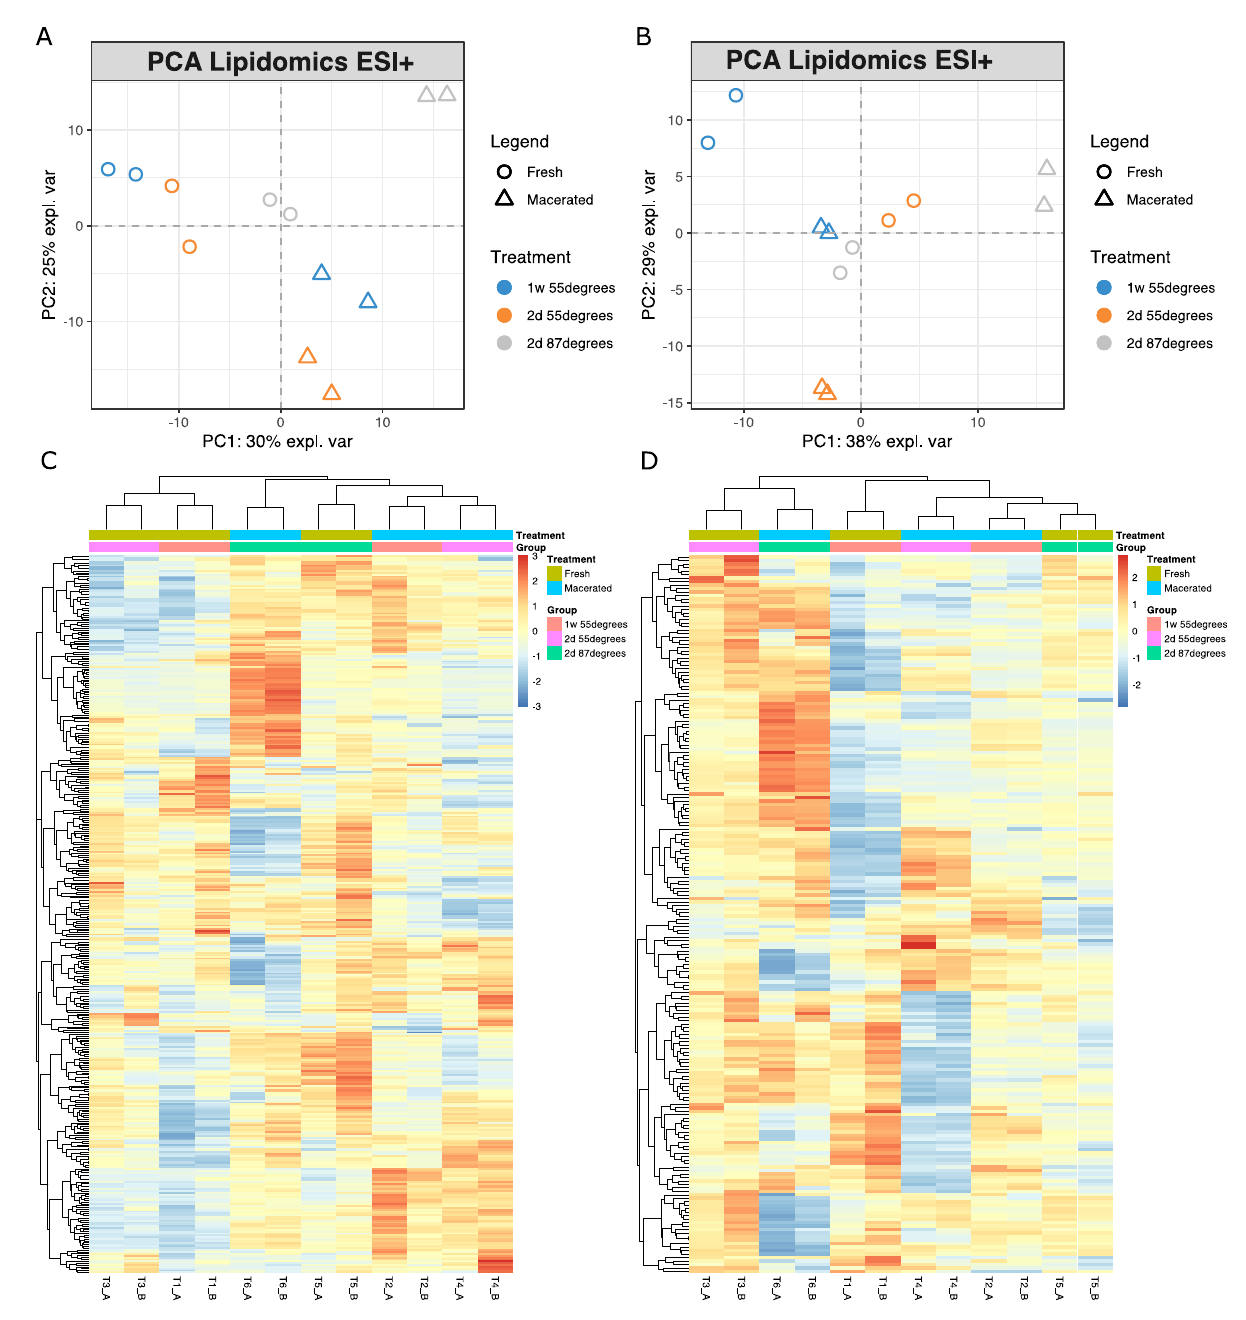
Figure 4. PCA plots lipid profiling in ESI+ ( A ) and ESI − ( B ) show a good separation between each treatment, while the separation between fresh and macerated specimens is less clear than in the metabolomics profile. Hierarchical clustering and heatmaps ( C , D ) show groups of macerated and non-macerated samples not clustering